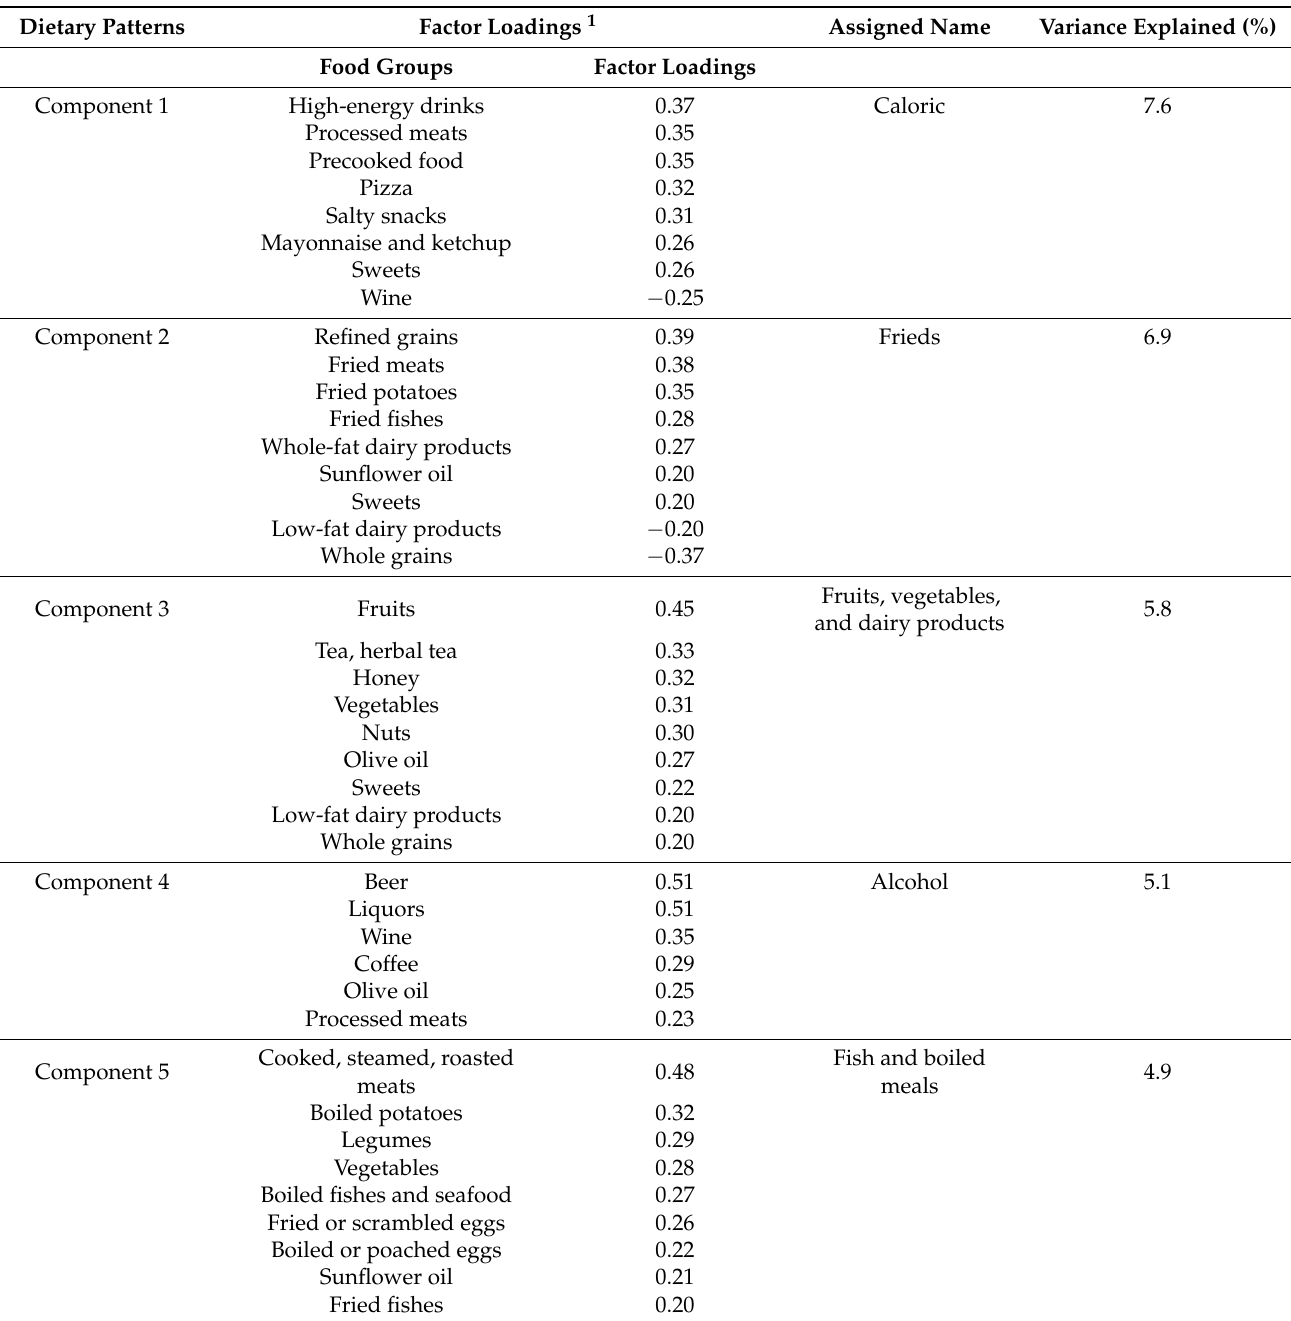
Table 3. Structures of the dietary patterns identified at